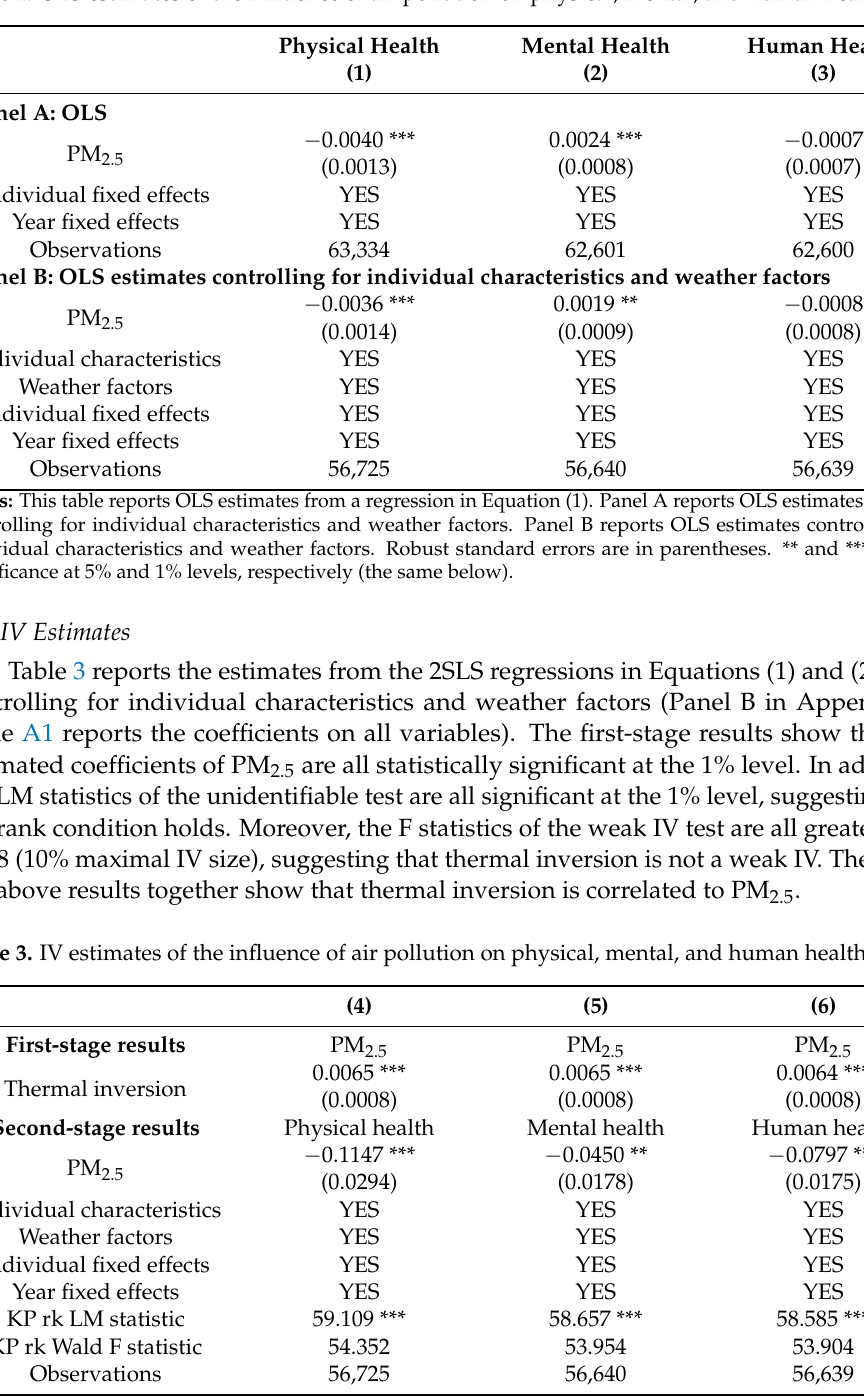
Table 2. OLS estimates of the influence of air pollution on physical, mental, and human health.